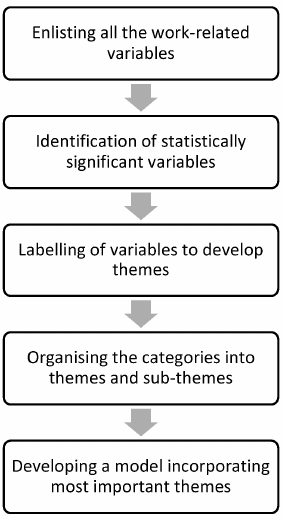
Figure 2. Adapted Coding Process in Inductive Analysis.